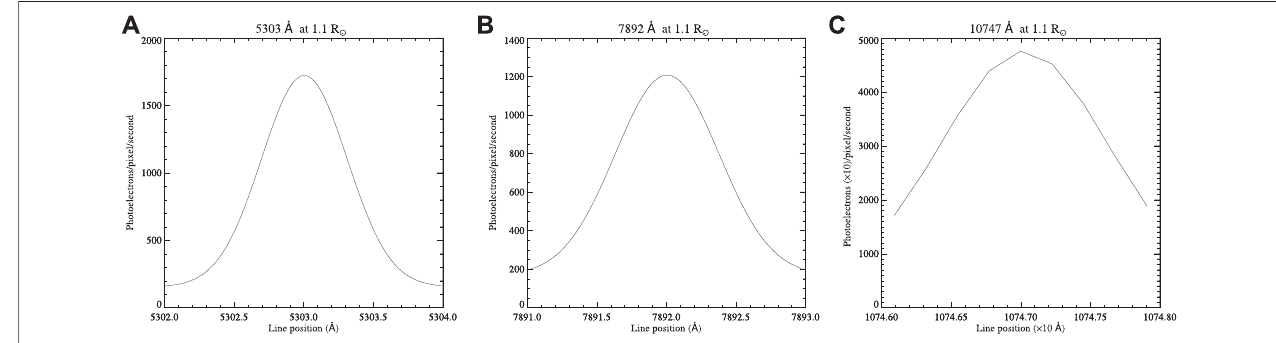
FIGURE1| SyntheticspectraforVELCat1.1 R ʘ for (A) 5,303 Å, (B) 7,892 Å,and (C) 10,747 Åfor50 μ mslitwidthattheirrespectivelineformationtemperatures. Photons due to instrument scattering are added to the